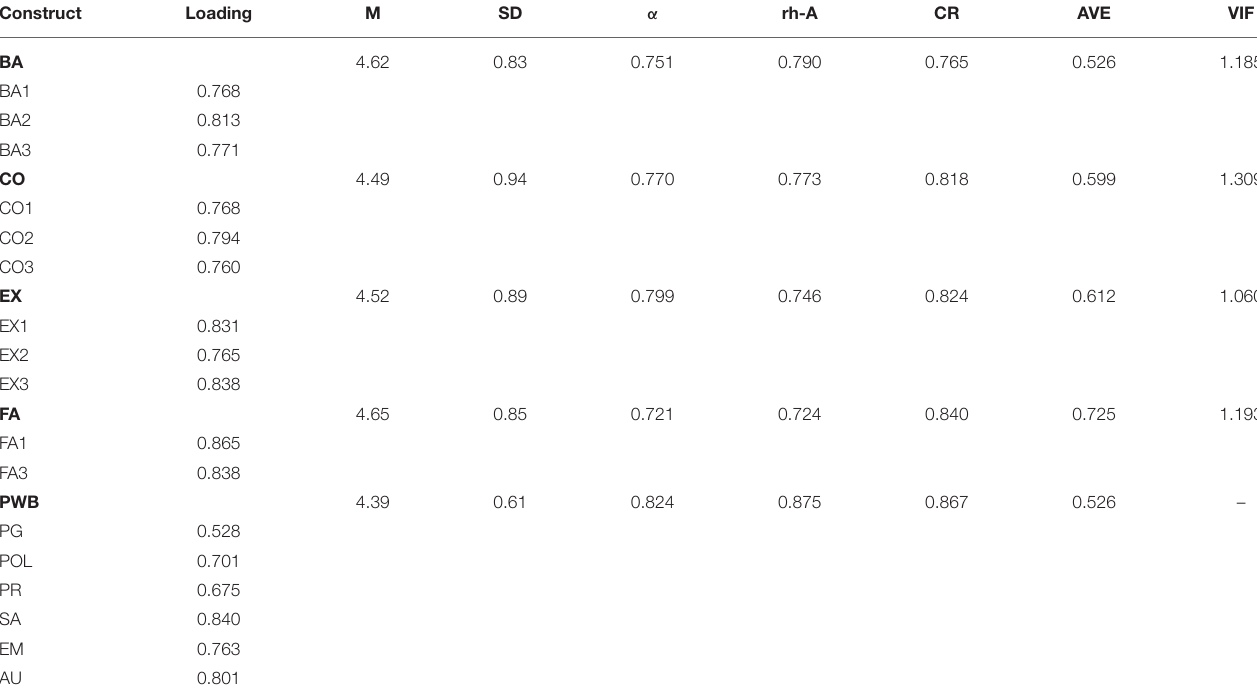
TABLE 2 | Partial least squares-confirmatory factor analysis (PLS-CFA) results.